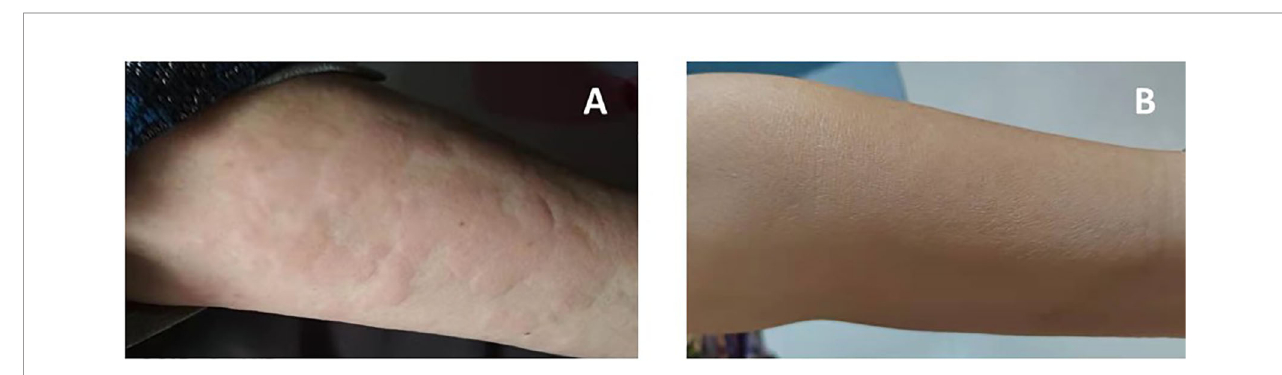
FIGURE 1 | Resolution of urticarial rash after BTK inhibitor ibrutinib therapy [ (A) pre-treatment; (B)